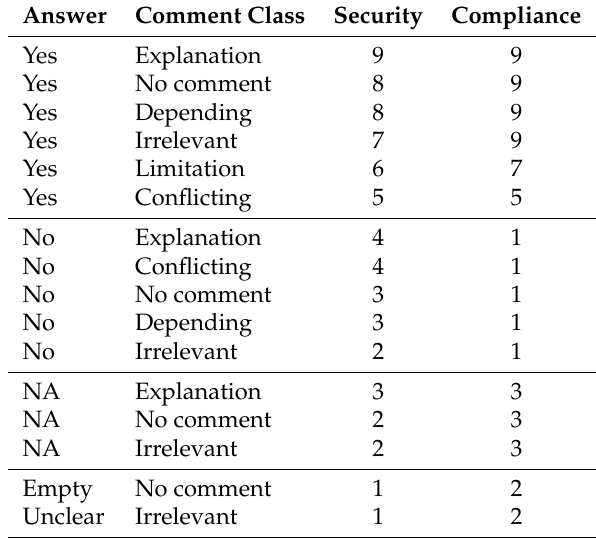
Table 7. Possible Scoring for Tenants Interested in Security or Compliance.